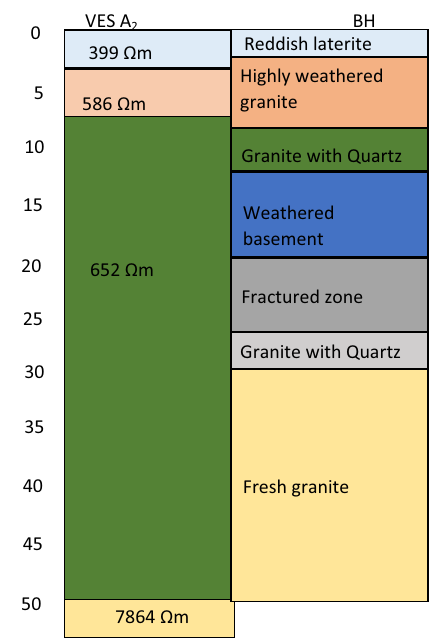
(a) Correlation of VES data with nearby Borehole Log